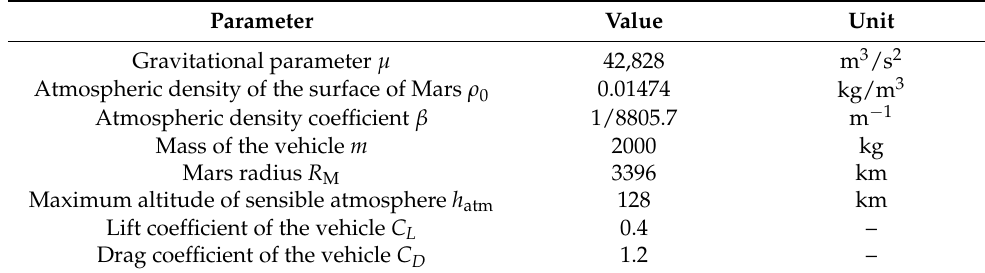
Table 1. The physical constants. Parameter Value Unit Gravitational parameter µ 42,828 Atmospheric density of the surface of Mars ρ